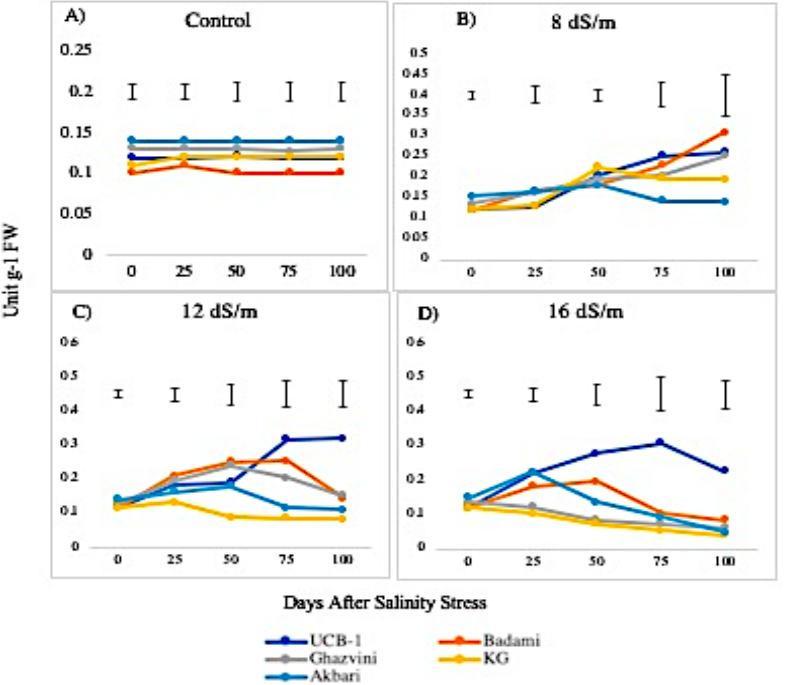
Figure 10. Effect of NaCl-mediated stress at 100 days of treatment on GR activity in leaves of pistachio.